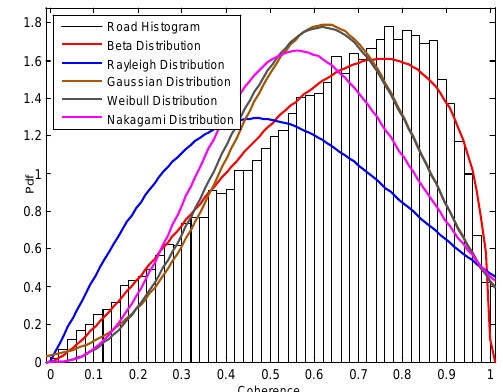
Figure 3. The performances of different statistical models for roads.